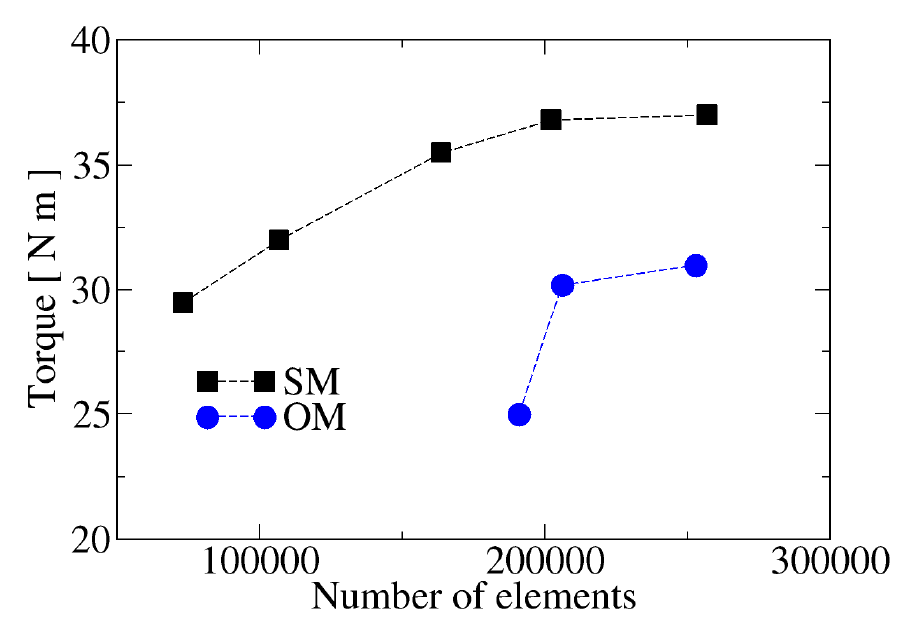
Figure 6. Convergence results for both techniques at TSR = 2.